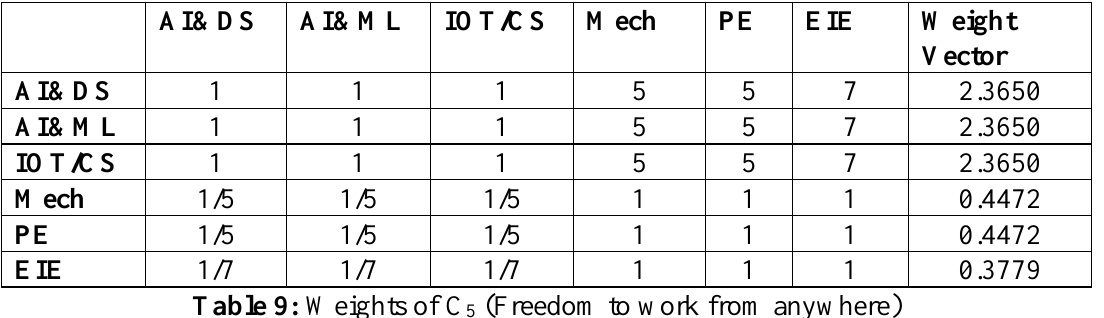
(Wide career options and career stability) 4